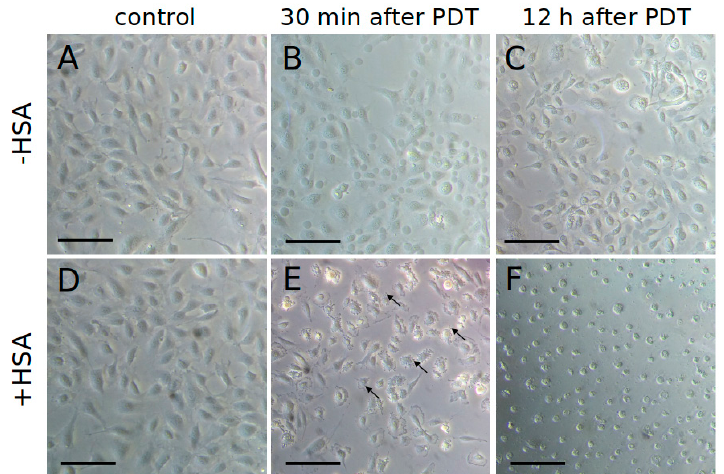
Figure 7. Morphology of HUVEC cells 30 min or 12 h after PDT. The cells accumulated Zn-Pheide (1 µM) in the absence ( A – C ) or presence ( D – F ) of HSA (250 µM). The control cells were incubated in the dark. The arrows indicate the apoptotic bodies formed after PDT performed in the presence of HSA. The scale bars represent 50 µm. The observed differences in the morphology of PDT-subjected cells prompted us to confirm the type of cell death with additional methods: flow cytometric analysis with Annexin V/propidium iodide staining and confocal microscopy study after the staining of the nuclei with Hoechst 33342. In order to examine whether albumin has a direct effect on the type of cell death, or if its role is limited to the decrease of the PS absorption, in these experiments we included three groups of cells. The first group was incubated with 1 µM Zn-Pheide without HSA, the second with 100 nM Zn-Pheide also without HSA, and the third with 1 µM Zn-Pheide in the presence of 250 µM HSA. We chose the concentration of 100 nM, since it resulted in a similar intracellular level of Zn-Pheide, as in the case of the incubation performed with 1 µM Zn-Pheide in the presence of 250 µM HSA (data not shown). Additionally, the corresponding controls were prepared by the treatment of the cells with either HSA-free or HSA-containing culture medium with the appropriate concentration of DMSO. Since no visible differences were observed between these controls, we only present the results obtained for the cells incubated in the presence of HSA. Staining with Hoechst revealed the shrinkage of nuclei (pyknosis) and chromatin condensation in the cells subjected to PDT after the incubation with 100 nM Zn-Pheide or 1 µM Zn-Pheide in the presence of HSA (Figure 8C,D). Counting the cells in which chromatin condensation was observed gave the same result of 66% apoptotic nuclei in both groups. Intranuclear chromatin condensation was widespread with a variable distribution. In some nuclei, clumps of chromatin were visible over their entire surface,